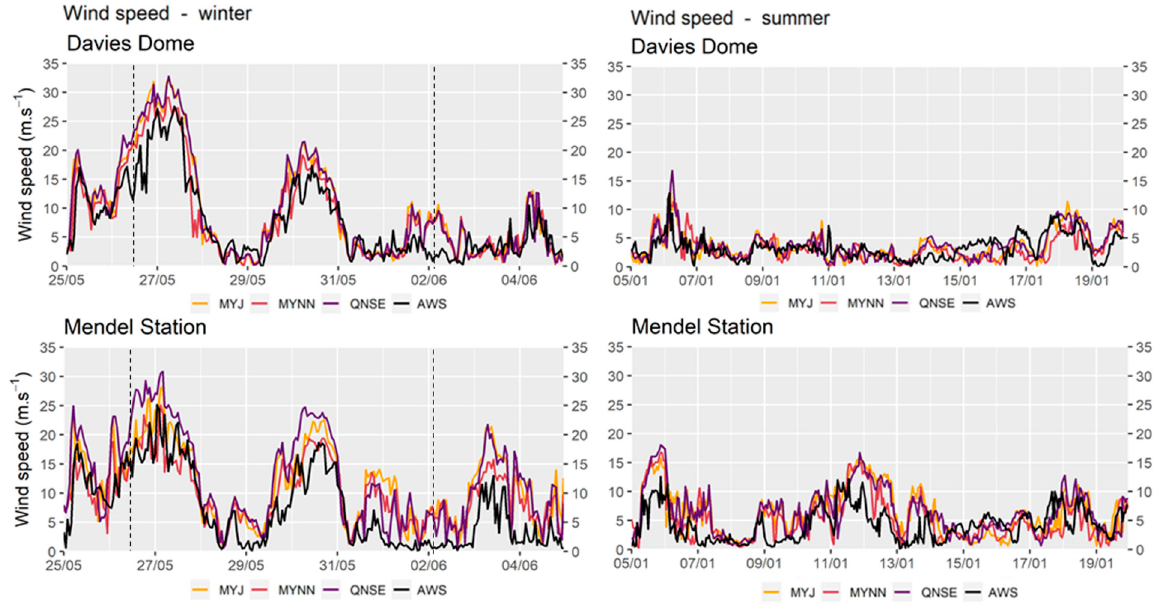
Figure 3. Time series of hourly observed wind speed at selected automatic weather stations on Ulu Peninsula in winter period ( left ) and summer period ( right ) compared with the corresponding WRF model outputs for three boundary layer schemes (MYJ, MYNN, QNSE). The dashed vertical lines represent time steps described in detail in Section 3.5.